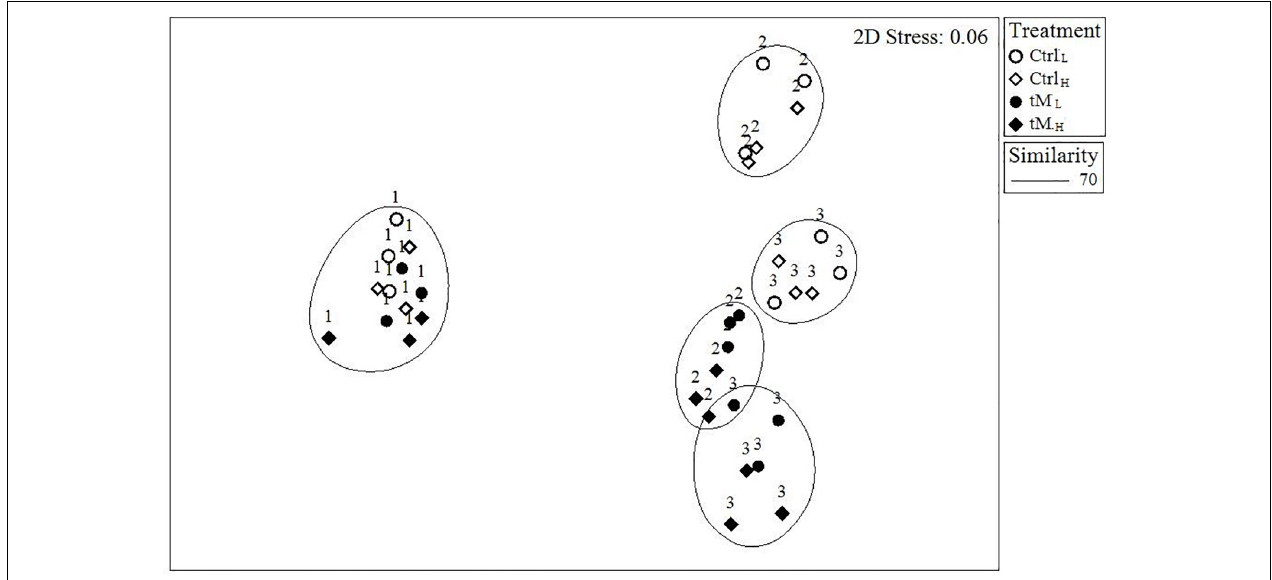
FIGURE 4 | Non-metric multidimensional scaling (NMDS) plot of the phytoplankton community composition. Numbers display the sampling day (1 = Day 0, 2 = Day 17, and 3 = Day